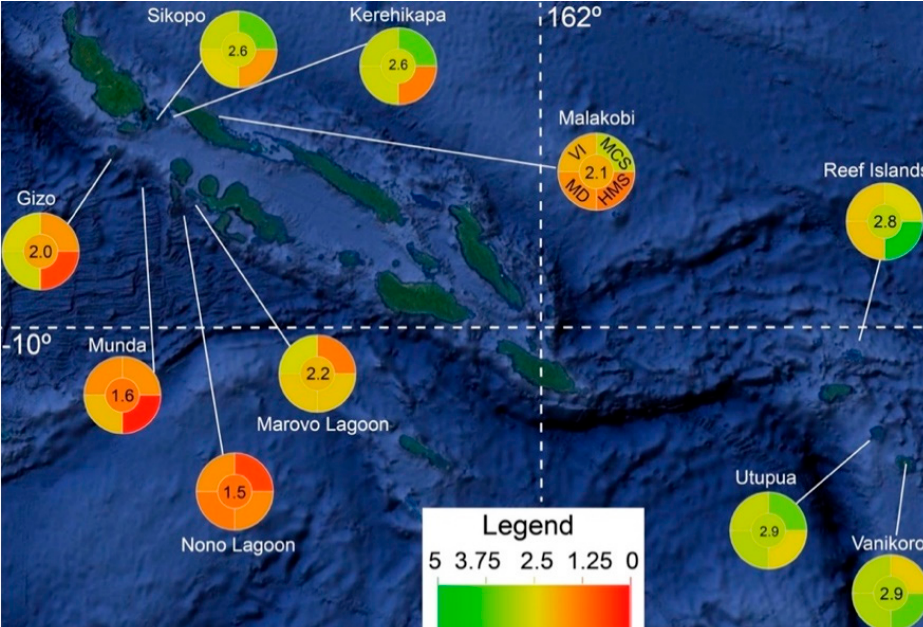
Figure 2. Map of the Solomon Islands with mean “coral health index” (CHI) scores plotted. The upper left, upper right, lower left, lower right, and center wedges of the pie graphs represent the variability index (VI), mean color score (MCS), Mahalanobis distance (MD), heat map score (HMS), and CHI, respectively (as depicted in the Malakobi pie graph).